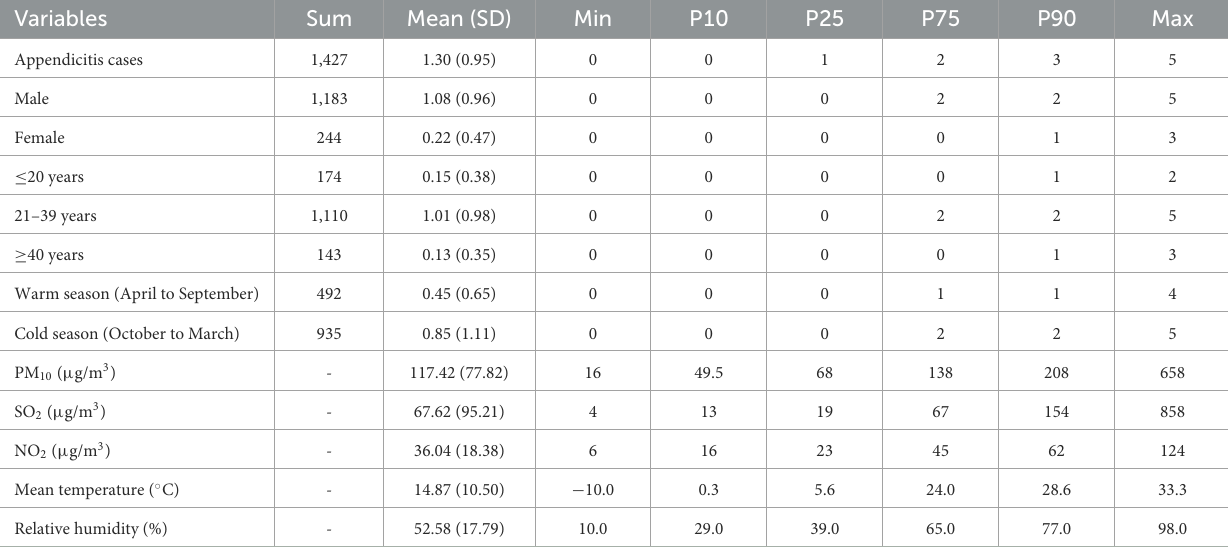
TABLE 1 Basic description of appendicitis admissions, pollutant concentrations and meteorological factors in Linfen, China, 2016–2018. Variables